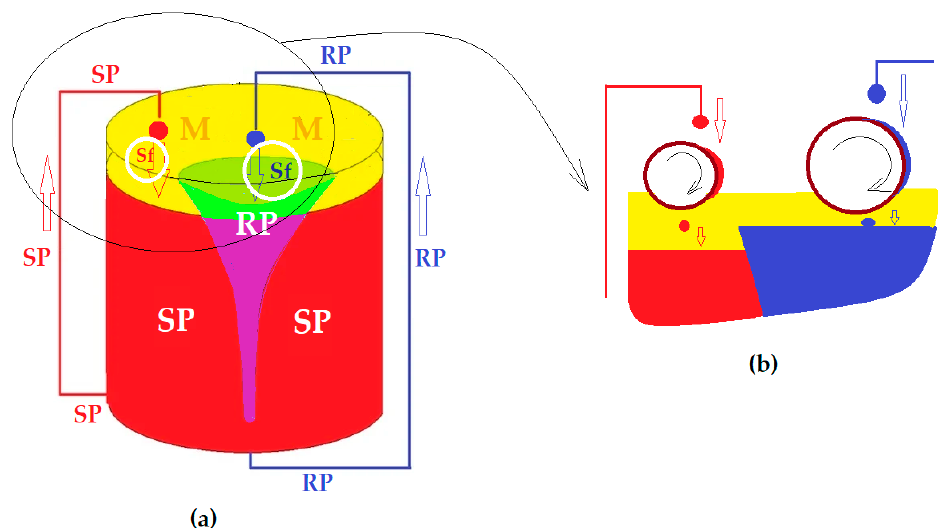
Figure 3. Schematic presentation of the permeation module with dispersed phases with spheres: ( a ) the idea of positioning the spheres; ( b ) how to extend the surface of the aqueous phases from the drop, as a film on the considered spheres. SP, source phase; RP, receiving phase; M, organic solvent membrane; Sf, spheres.